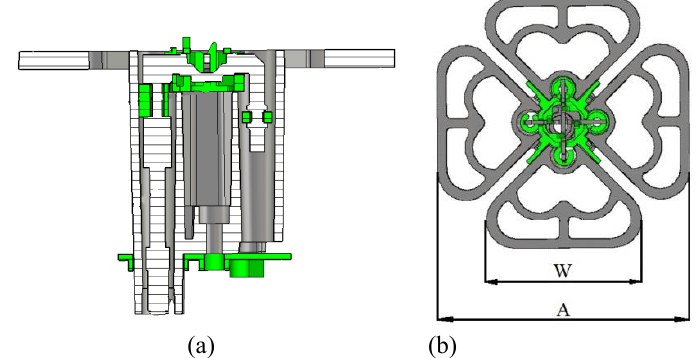
Fig. 1 . (a) cross section of the crossed dipole , (b) top view of the crossed